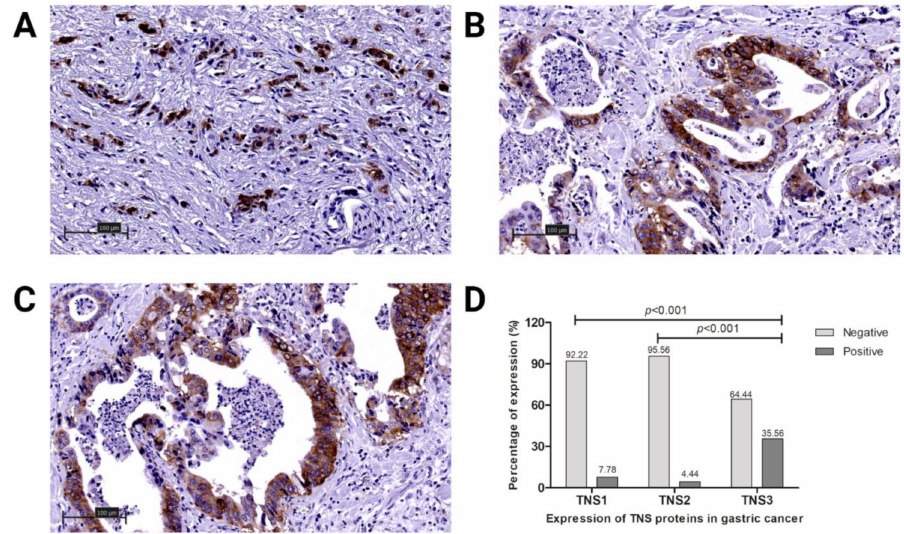
Figure 1. Tensin (TNS) protein expression levels in gastric cancer (GC): ( A ) TNS1 in non-differentiated GC, magnification, × 200; ( B ) TNS2 in moderately differentiated GC, magnification, × 200; ( C ) TNS3 in moderately differentiated GC, magnification, × 200; ( D ) comparison of TNS1-3 in GC. Statistical analysis performed using Student’s t